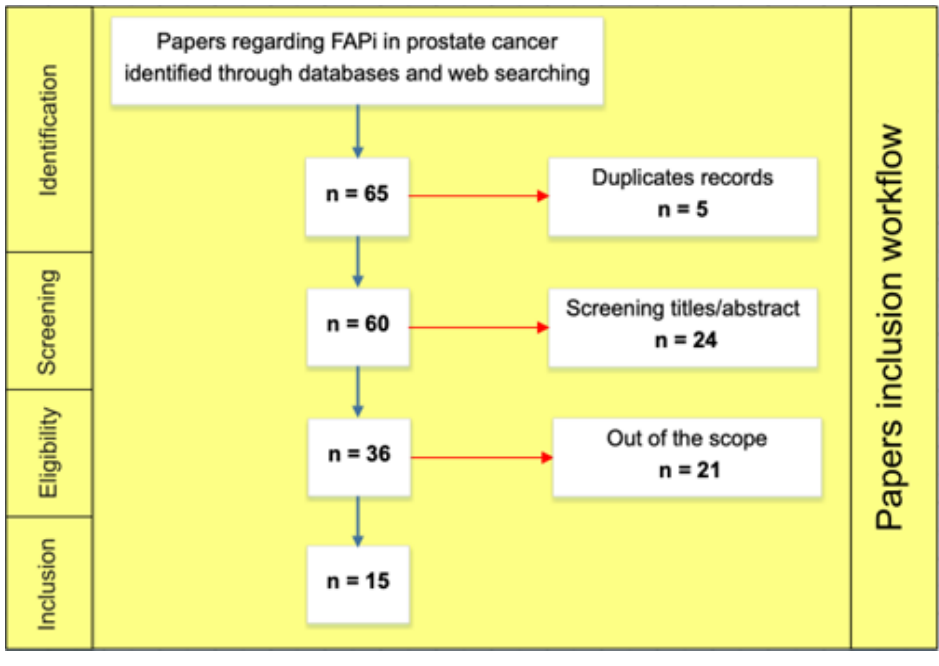
Figure 1. Paper inclusion workflow.